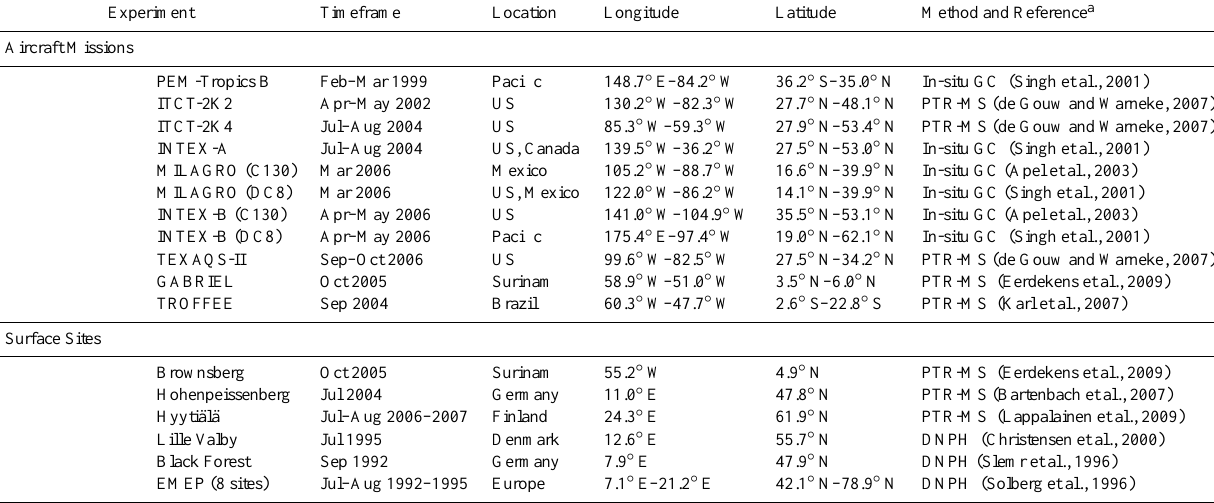
Table 3. Aircraft and Surface Measurements of Acetaldehyde used for Model